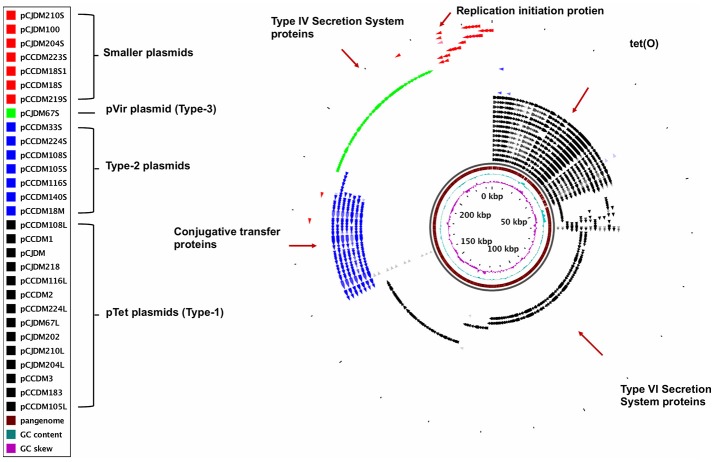
Different types of plasmids identified in our study. Circular Figure represents the pangenome analysis for all plasmid sequences from our laboratory. Individual slot (circle) in the figure represent one plasmid sequence. Pangenome analysis for all plasmid sequences was completed with GView server.